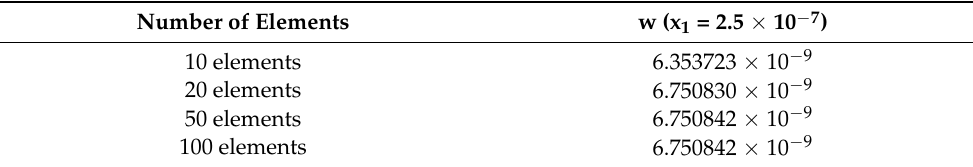
Table 1. Convergence of numerical results for the midpoint deflection with respect to the number of discretization